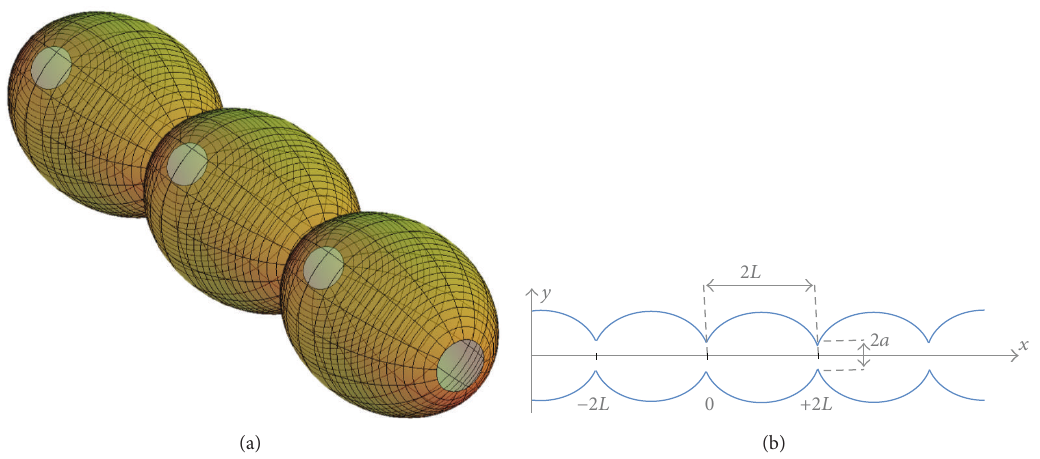
Figure 2: Periodic elliptic tube. (a) A tube made of juxtaposed elliptic sections (each an elliptic tube as depicted in Figure 1) is called a periodic elliptic tube. Its shape is schematically shown in (b).